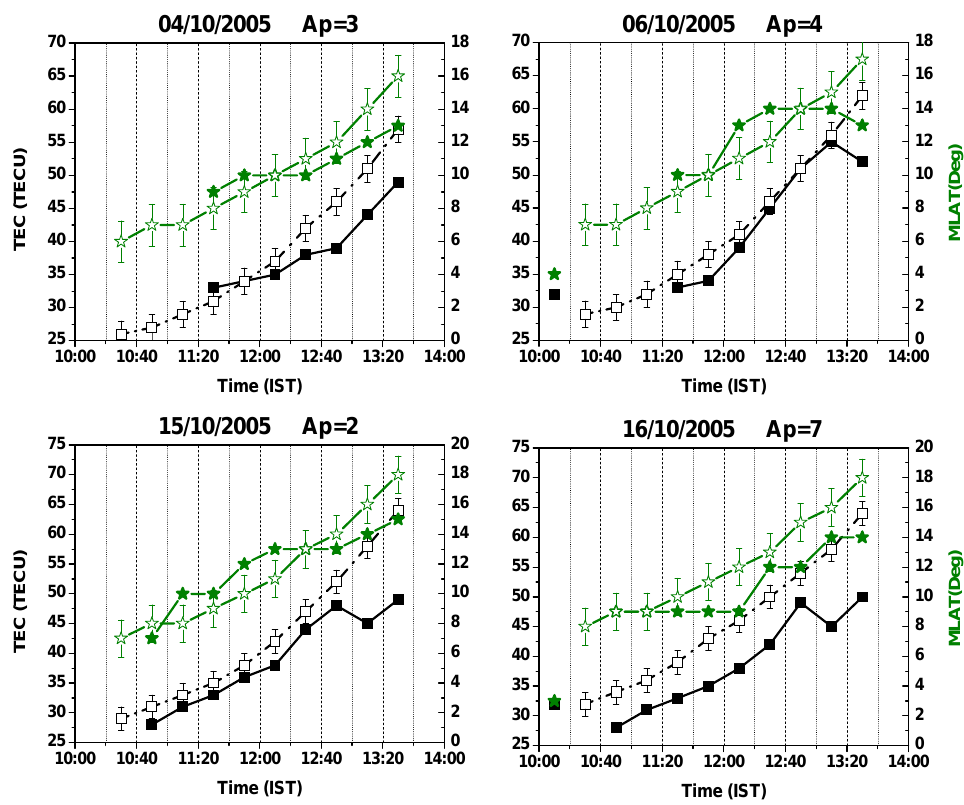
Fig. 8. Same as Fig. 5 but for few days in 2005, which are not gone in to the time delay